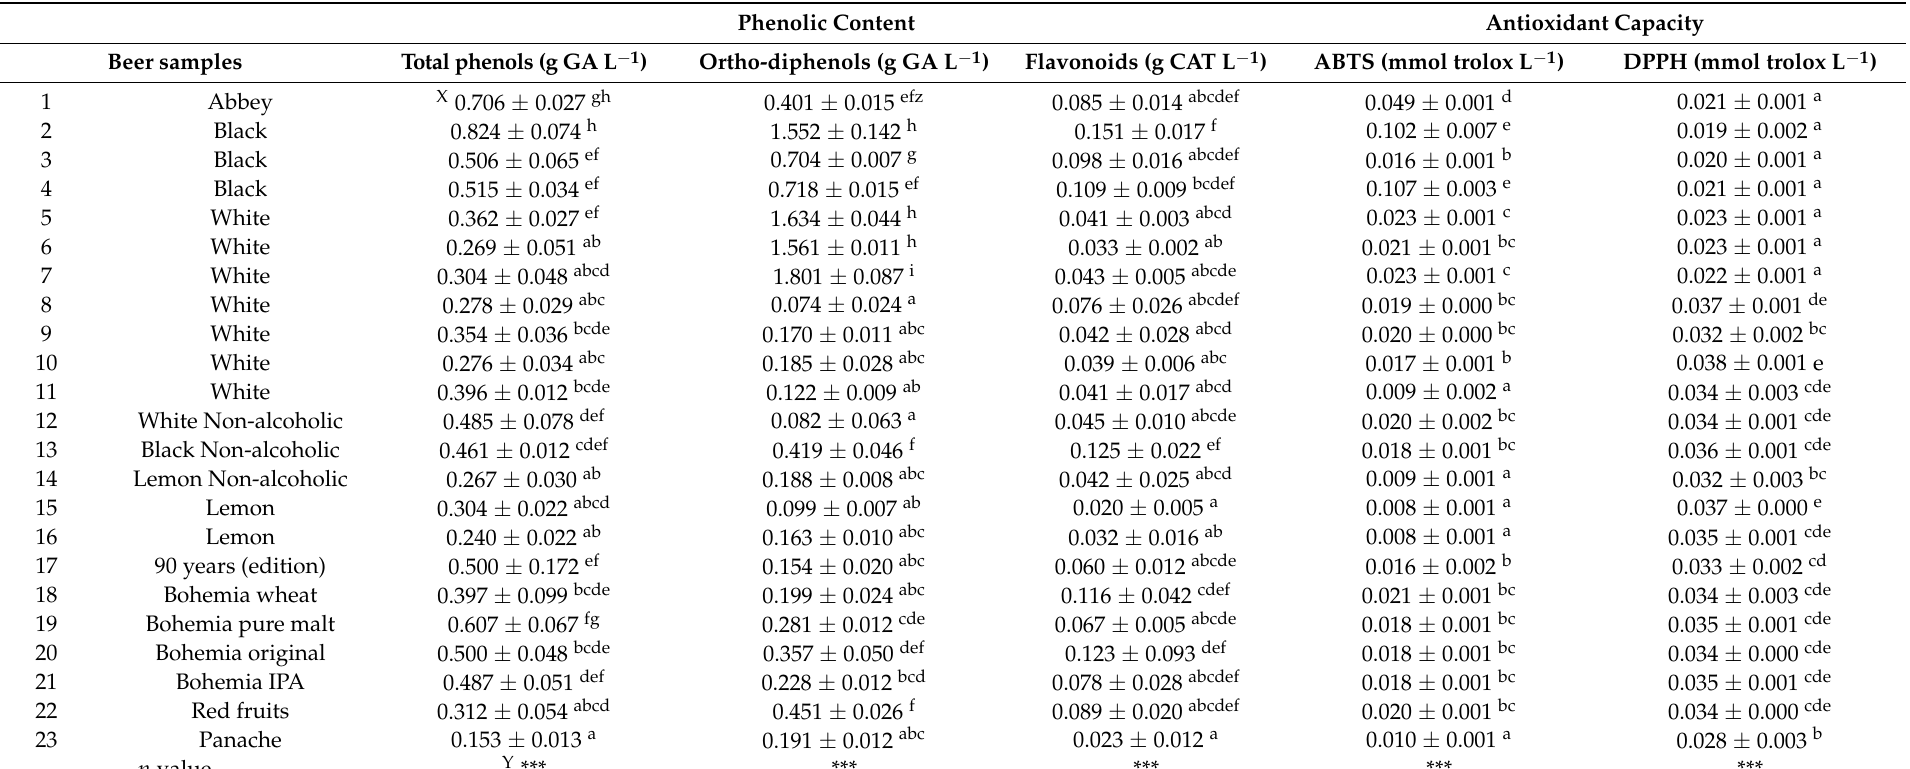
Table 2. Phenolic content and antioxidant capacity of Portuguese